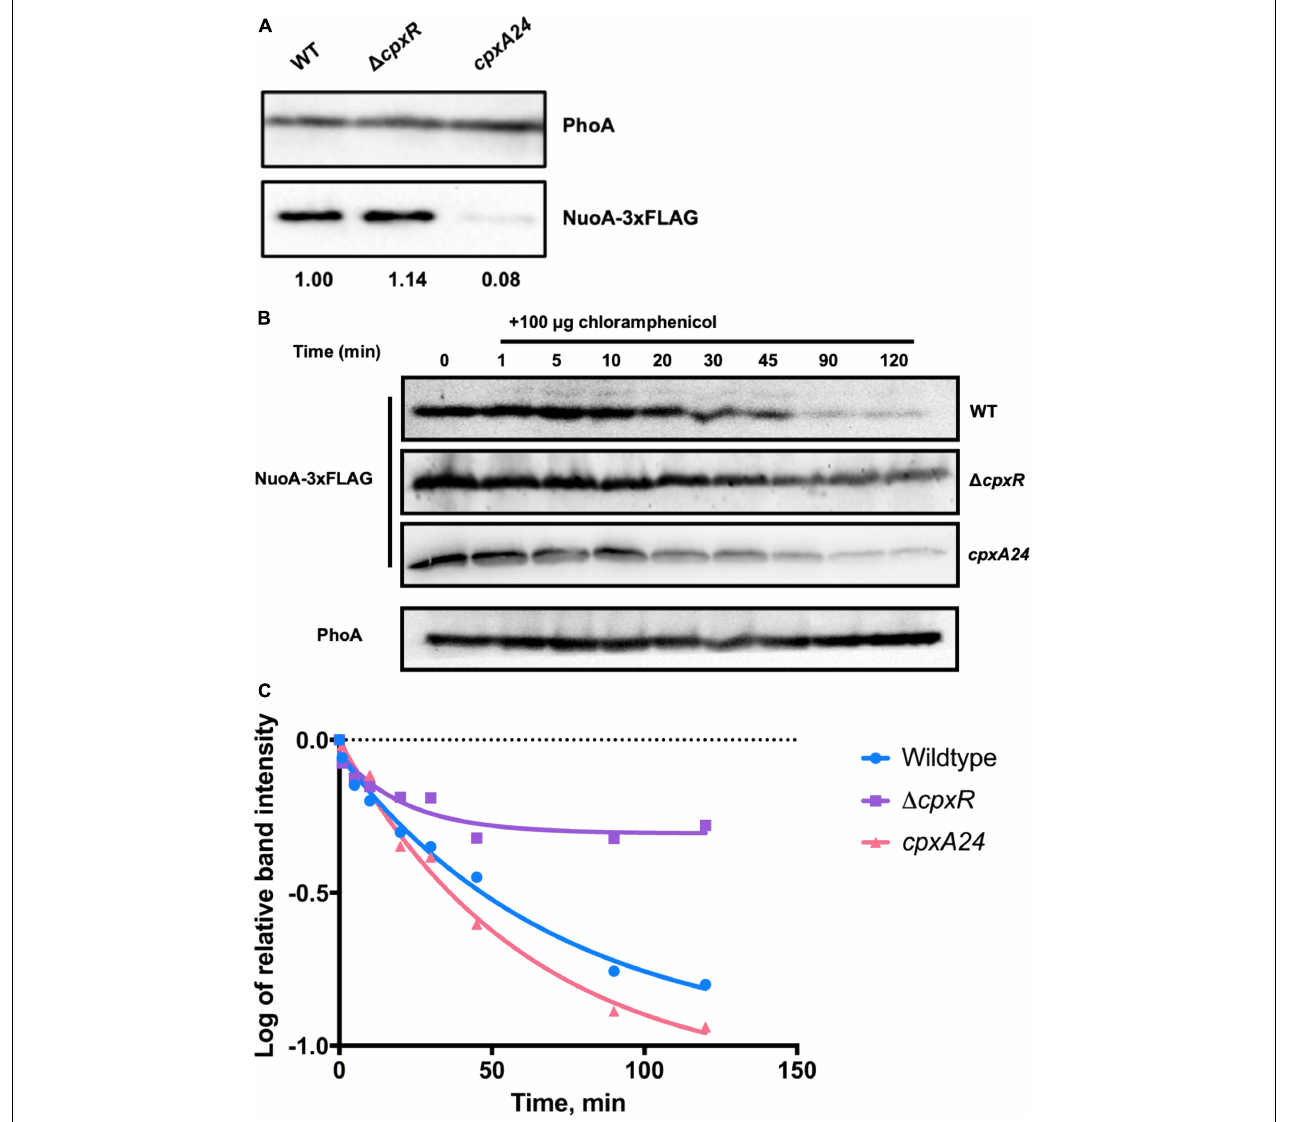
FIGURE 4 | The Cpx response affects NuoA-3 × FLAG protein levels. Western blots utilizing anti-FLAG tag antibody were performed on wildtype EPEC, cpxA24 or (cid:49) cpxR mutants (A) or wildtype BW25113, cpxA24 or (cid:49) cpxR mutants (B,C) containing the pMPM- nuoA -3 × FLAG expression vector (A) at a single time-point, where band intensity is represented by the value relative to the wildtype NuoA-3 × FLAG protein level and (B) over time after 100 µ g of chloramphenicol was added to inhibit protein synthesis. Samples were taken at 0 (before addition) 1, 5, 10, 20, 30, 45, 90, and 120 min after addition to assay NuoA-3 × FLAG protein degradation. PhoA protein levels served as a loading control. Proteins were detected using the Immun-Star alkaline phosphatase chemiluminescence kit (Bio-Rad) and the Bio-Rad ChemiDoc MP imaging system. (C) Relative band quantification was performed using band intensity analysis in ImageJ. The protein stability assay data were fit with a one-phase exponential decay curve to determine protein half-life using the Prism v7.0c (GraphPad)